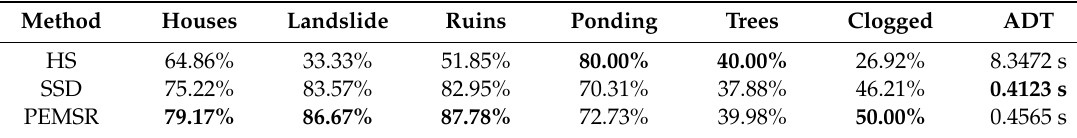
Table 6. F1 score results of the three methods on the original data. HS refers to the F1 score results of the HOG + SVM method, ADT refers to the average detection time and the bold values are the best results among the three